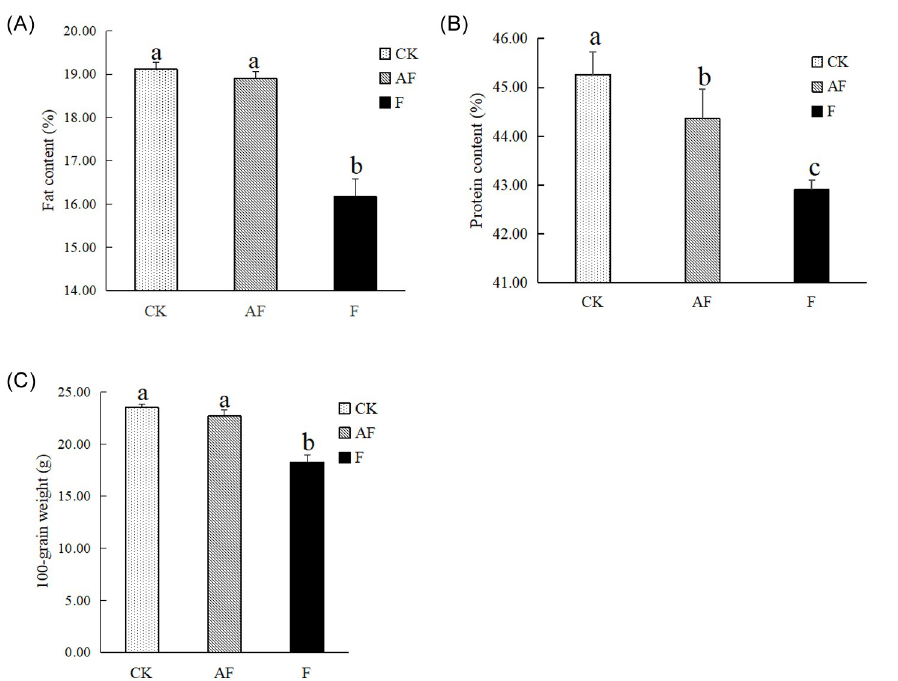
Fig 3. Soybean growth indexes. The x-axis means different treatment groups, CK, control group; AF, soybean planted in continuously cropped soil inoculated at 44 d after sowing and evenly mixed with F . mosseae ; F, soybean planted in continuously cropped soil inoculated with F . oxysporum at 44 d after sowing. (A) The y-axis means soybean fat content. (B) The y-axis means soybean protein content. (C) The y-axis means soybean 100-grain weight.